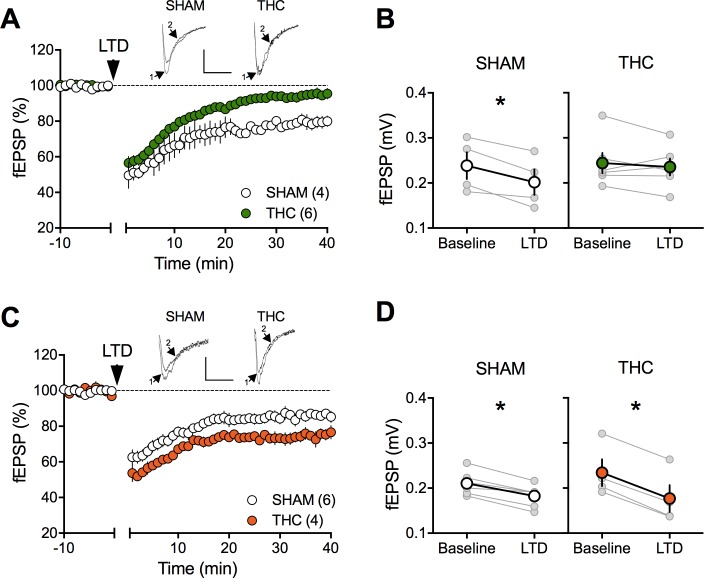
Sexual divergent ablation of LTD in the PFC of adult rats prenatally exposed to THC.(A) Average time-courses of men field EPSPs showing that low-frequency stimulation (10 min at 10 Hz, arrow) induced LTD of evoked fEPSPs recorded in the mPFC in SHAM (n = 4; white circles), but not in THC (n = 6; green circles) prenatally-exposed male rats. Above: example traces, baseline (1) and 40-min poststimulation (2). (B) Individual experiments (grey) and group average (white represents SHAM; green represents THC), before (baseline) and after (40 min) LTD induction showing the lack of LTD in the THC exposed group. In SHAM rats: 0.239 ± 0.030 mV before LTD versus 0.202 ± 0.028 mV after LTD induction (n = 4, p<0.05, paired t-test). In THC animals: 0.244 ± 0.023 mV before LTD versus 0.236 ± 0.019 mV after LTD induction (n = 6, p>0.05, paired t-test). (C) Average time-courses of mean EPSPs showing similar low-frequency LTD in SHAM (n = 6; white circles) and THC (n = 4; orange circles) in utero-exposed female rats. Above: example traces, baseline (1) and 40 min poststimulation (2). (D) Individual experiments (grey) and group average (white represents SHAM; orange represents THC), before (baseline) and after (40 min) LTD induction showing that prenatal THC exposure does not alter LTD in the female exposed group. In SHAM female rats: 0.211 ± 0.011 mV before LTD versus 0.183 ± 0.010 mV after LTD induction (n = 6, p<0.05, paired t-test). In THC female rats: 0.234 ± 0.030 mV before LTD versus 0.177 ± 0.030 mV after LTD induction (n = 4, p<0.05, paired t-test). *p<0.05. n = individual rats. Error bars indicate SEM. Scale bar: 10 ms, 0.1 mV.